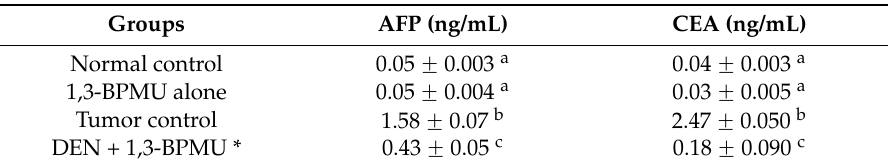
Table 4. Effects of 1,3-BPMU on cancer marker proteins α -fetoprotein and carcinoembryonic antigen in control and experimental groups of